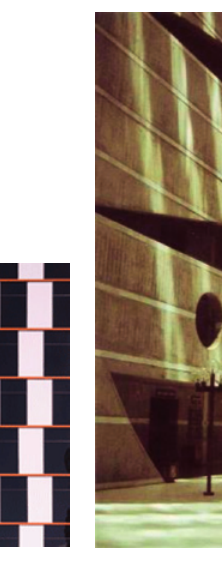
Fig. 8. ARM Architecture. Digital Harbour . 1010 Fig. 9. Louis Kahn. National